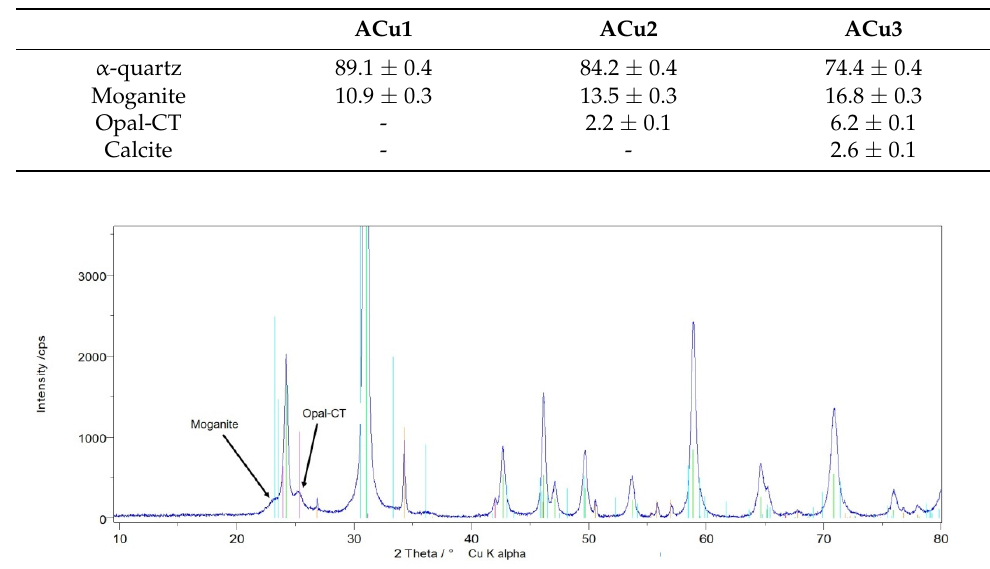
Figure 6. The microtexture of sample ACu1: ( a ) sequence of silica phases from the margin of the agate to the center with granular, microcrystalline quartz (gq), alternating layers of chalcedony with fine-grained quartz, fibrous chalcedony (fc) and macrocrystalline quartz (mq); ( b ) Nomarski DIC micrograph illustrating the differences in porosity between chalcedony and quartz layers; the